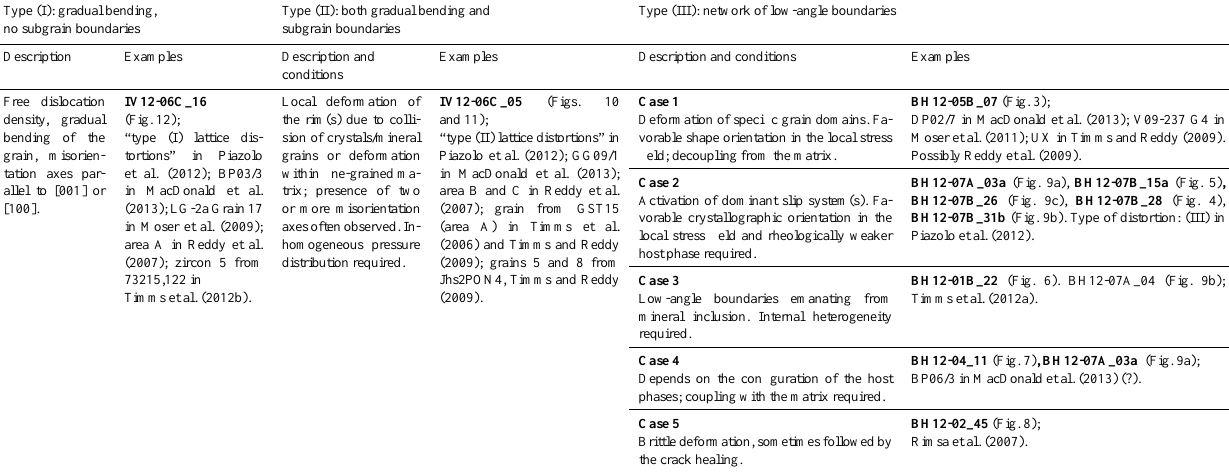
Table 2. Types of finite deformation patterns with examples from the present study and from the literature. Groups characterizing type (III) lattice distortion describe different mechanisms for the finite deformation pattern formation